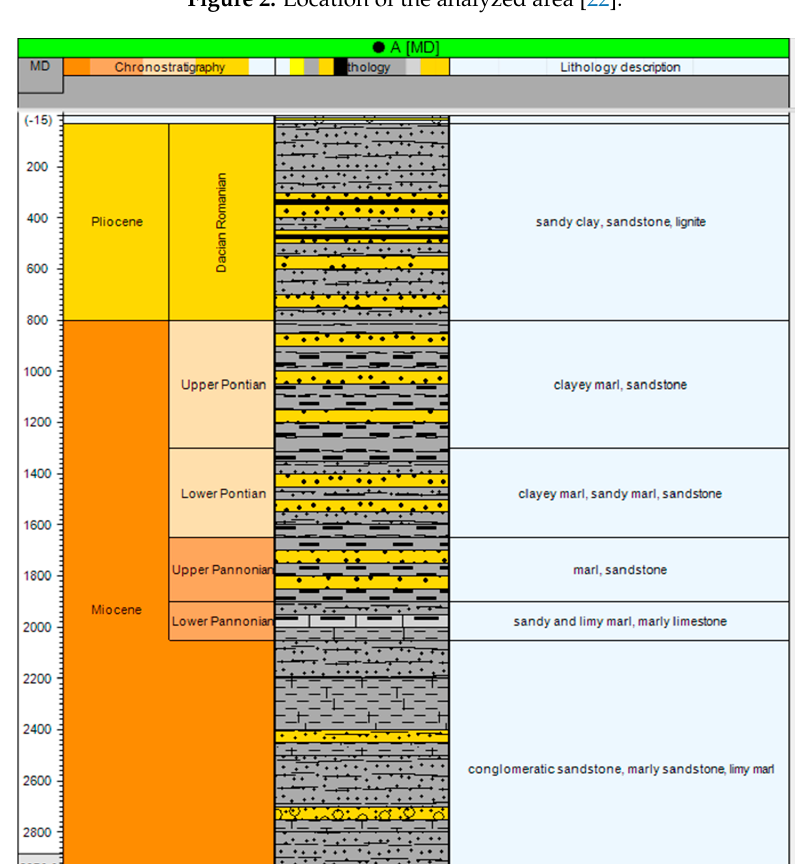
Figure 3. General chronostratigraphy–lithofacies column of field “A”.